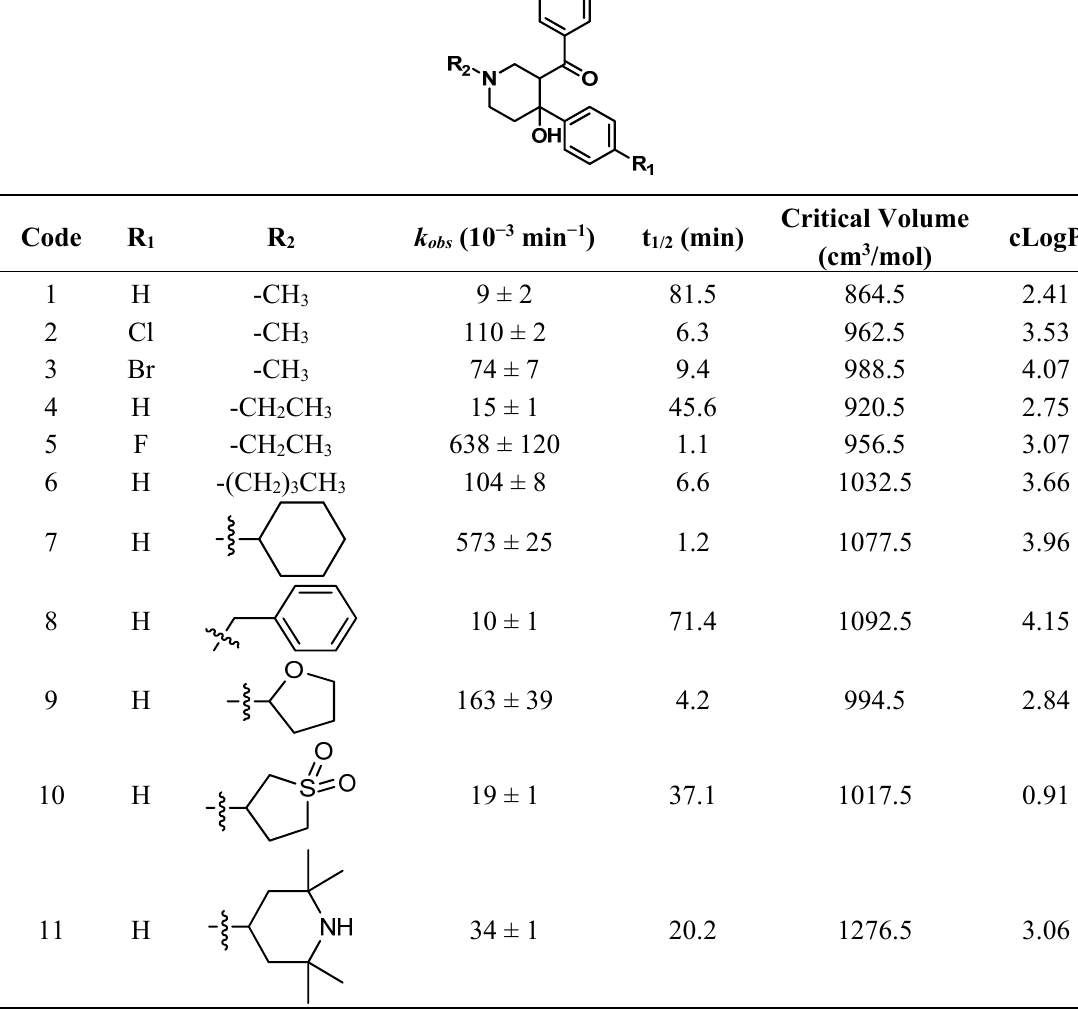
Table 1. The time-dependent activity of the piperidinols against